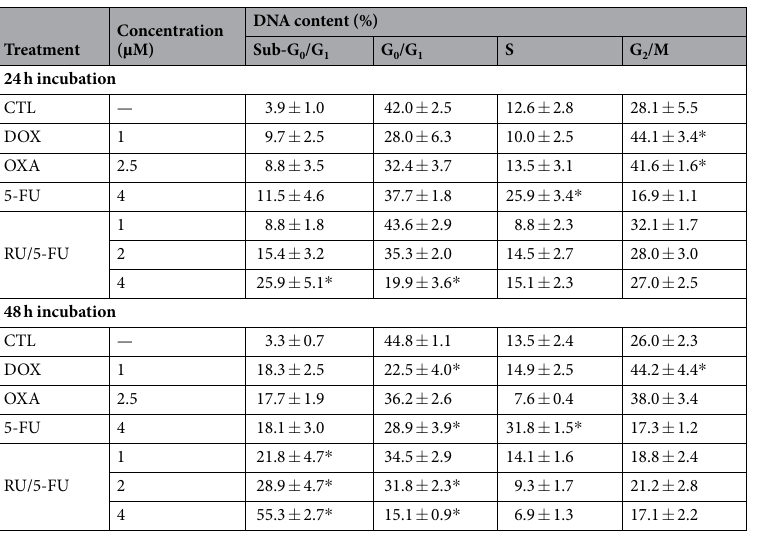
Table 3. Effect of the complex [Ru(5-FU)(PPh 3 ) 2 (bipy)]PF 6 (RU/5-FU) in the cell cycle distribution of HCT116 cells. Data are presented as the mean ± S.E.M. of three independent experiments performed in duplicate. The negative control (CTL) was treated with the vehicle (0.1% DMSO) used for diluting the compound tested. Doxorubicin (DOX), oxaliplatin (OXA) and 5-fluorouracil (5-FU) were used as the positive controls. Ten thousand events were evaluated per experiment and cellular debris was omitted from the analysis. * P < 0.05 compared with the negative control by ANOVA followed by Student Newman-Keuls